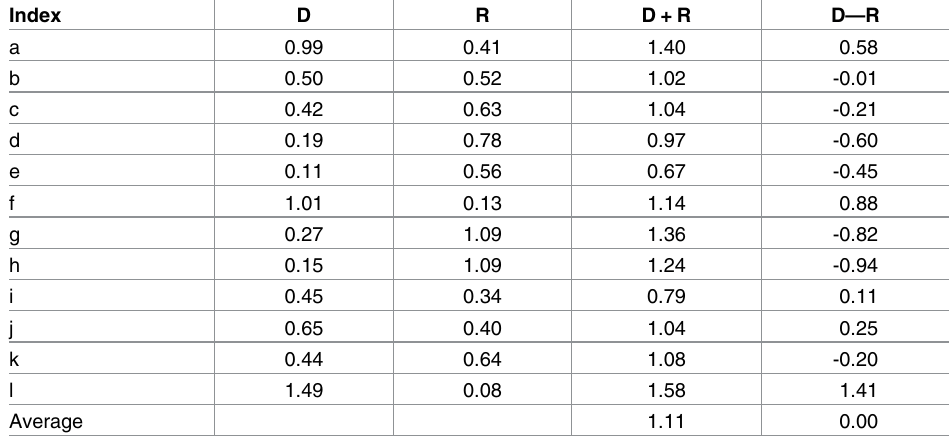
Table 5. Summary of the prominence and relation of the 12